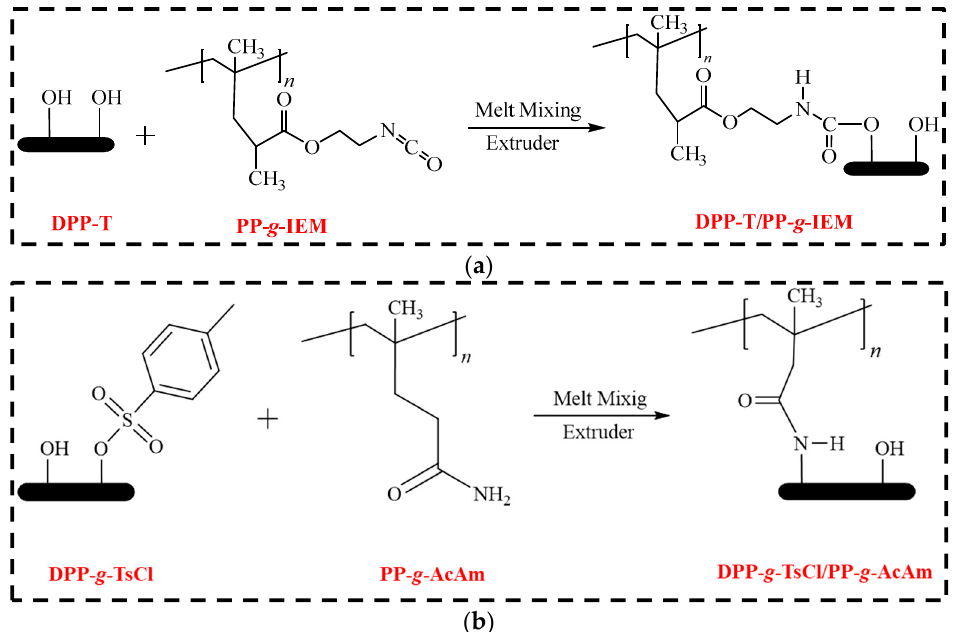
Scheme 5. Proposed coupling reactions of ( a ) DPP-T/PP- g -IEM and ( b ) (DPP-T)- g -TsCl-/PP- g